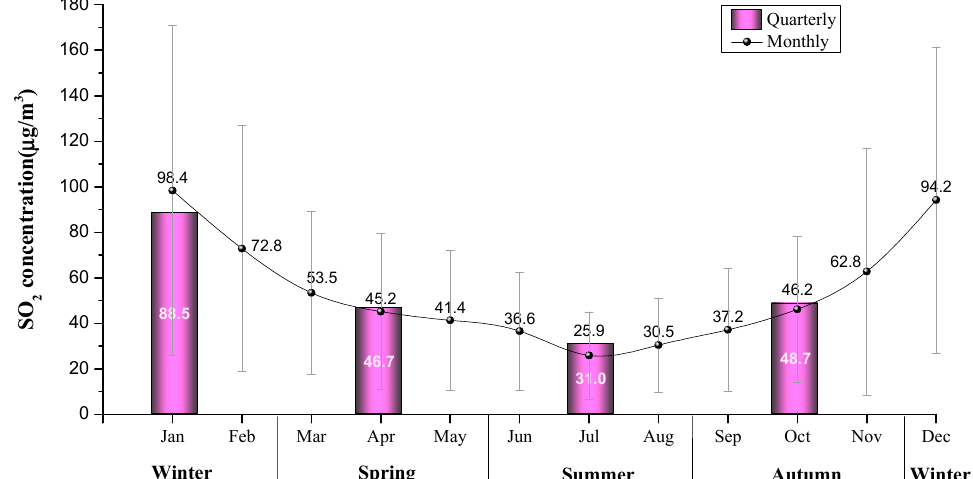
Figure 4. Seasonal and monthly average SO 2 concentration from 2008 to 2020. (The bars indicate average value ± S.D. The analysis was performed based on 38 observations.)